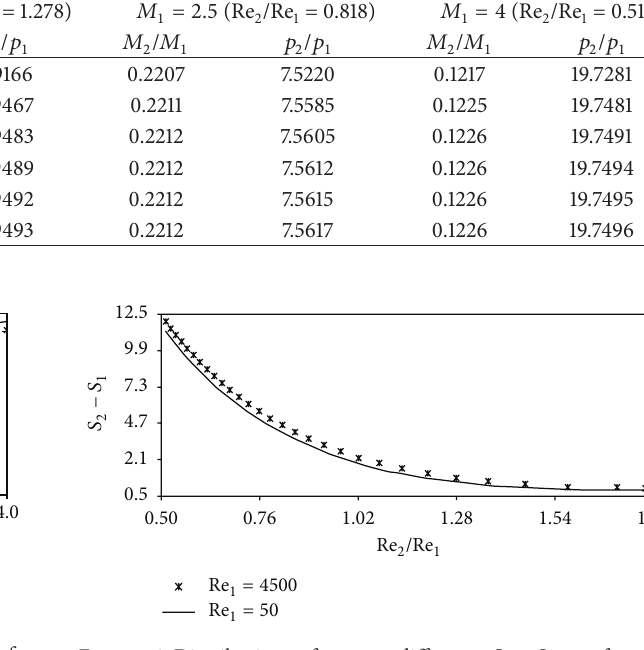
Figure 6: Distributions of entropy difference 𝑆 2 − 𝑆 1 as a function of Re 2 / Re 1 for two different values of Re 1 .